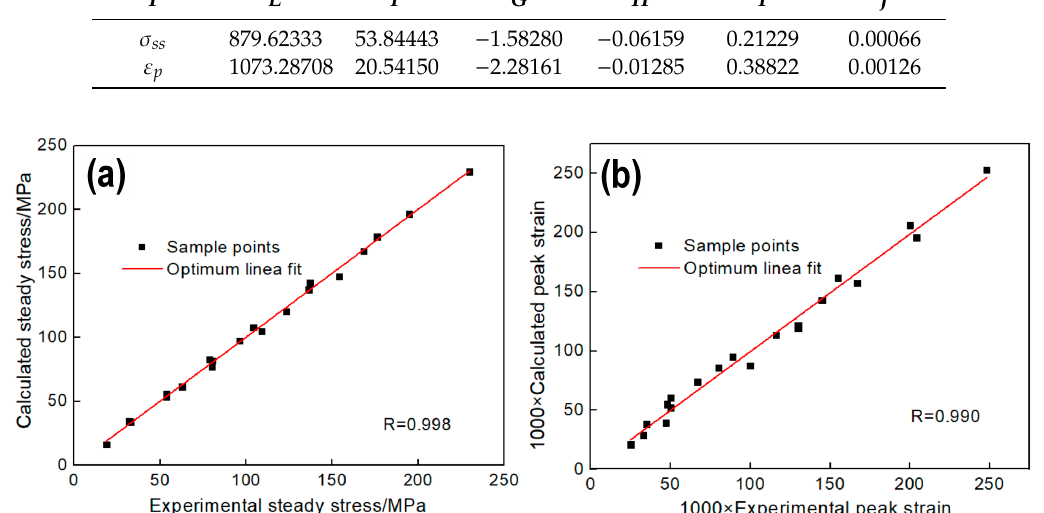
Table 7. The coe ffi cients of Equation (23) about σ ss and ε p . Table 7. The coefficients of Equation (23) about